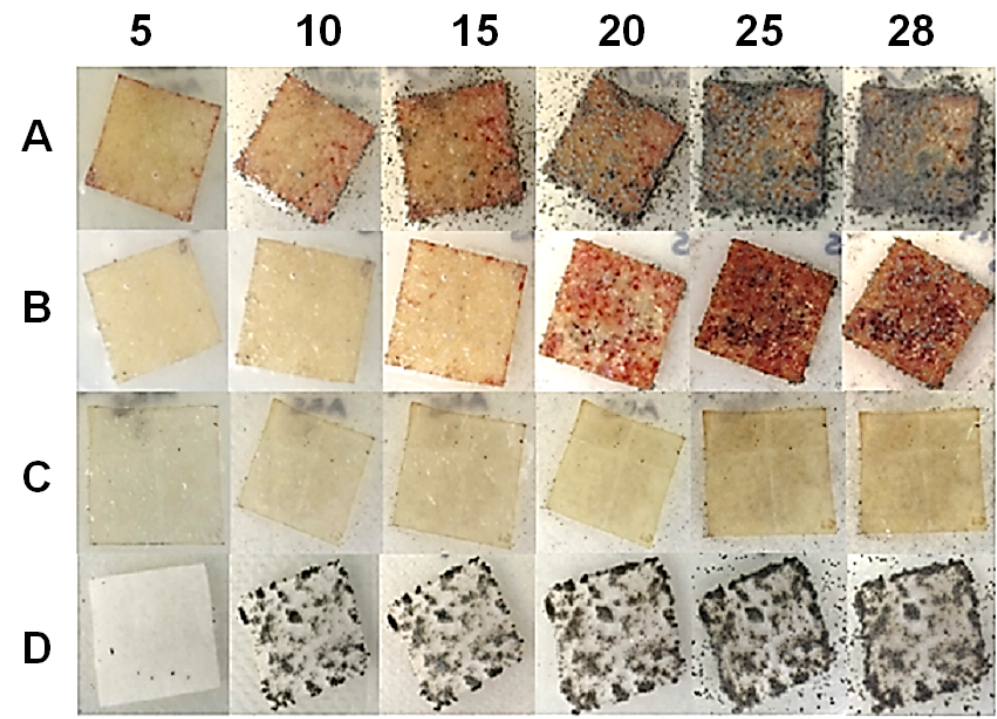
Figure 6. Biodegradability progress of cellulose films ( A ), cellulose nanocrystals ( B ), chitosan ( C ) and filter paper ( D ) observed on days 5, 10, 15, 20, 25 and 28 after inoculation of the spore mixture.